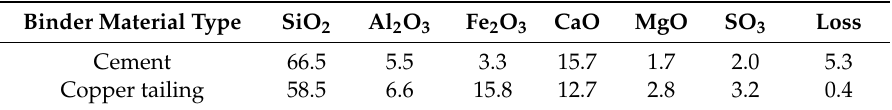
Table 1. Cementitious material chemical